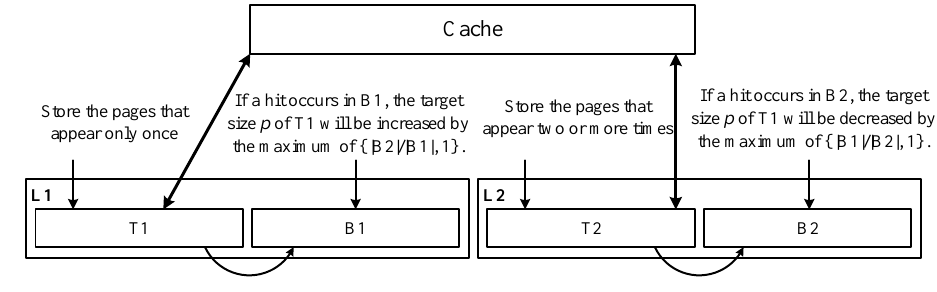
4. VBBMS : As shown in Figure 3, VBBMS [4] is a typical flash-aware buffer method to combine consecutive pages in the same virtual block. When the cache space is insufficient, VBBMS will evict the entire virtual block so that the data written to flash memory can be more sequential. By the eviction of the entire virtual block, VBBMS can easily make a block to have more invalid pages and reduce the overhead of the garbage collection. In addition, because random requests and sequential